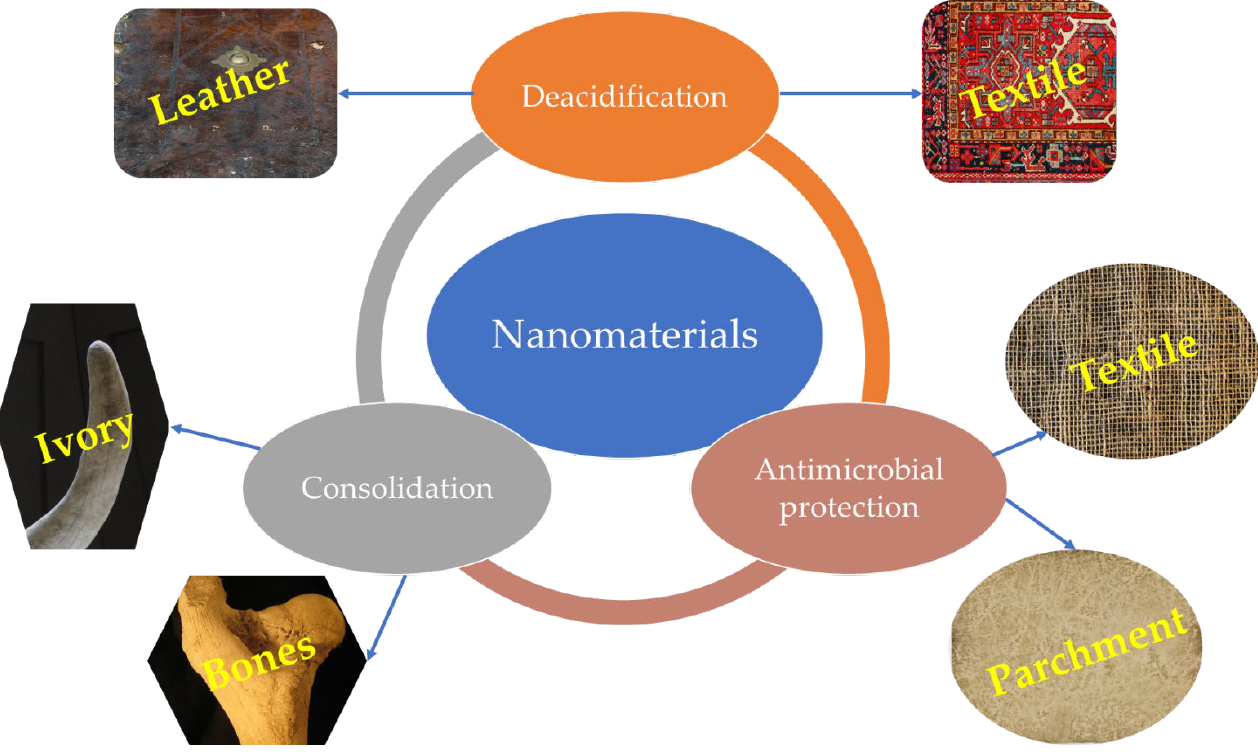
Figure 5. Examples of the nanomaterials’ applications in the conservation of other types of artifacts.